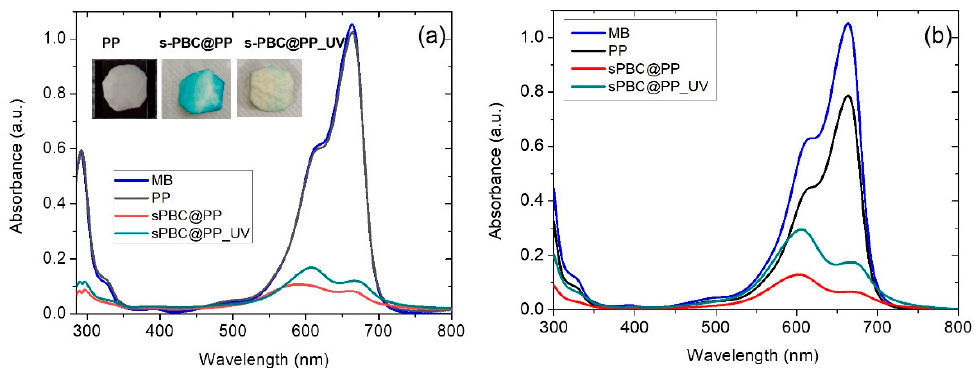
Figure 3. ( a ) UV-Visible absorbance spectra of MB solutions after dipping PP (black curve), s-PBC@PP (red curve), and s-PBC@PP_UV (green curve) for 3 h. In the inset a photo of each sample after three hours of adsorption; ( b ) UV-Visible absorbance spectra of MB solutions after filtration for PP (black curve), s-PBC@PP (red curve) and s-PBC@PP_UV (green curve) samples. The blue curve in both graphs represents the UV-Vis spectrum of MB at the initial concentration.